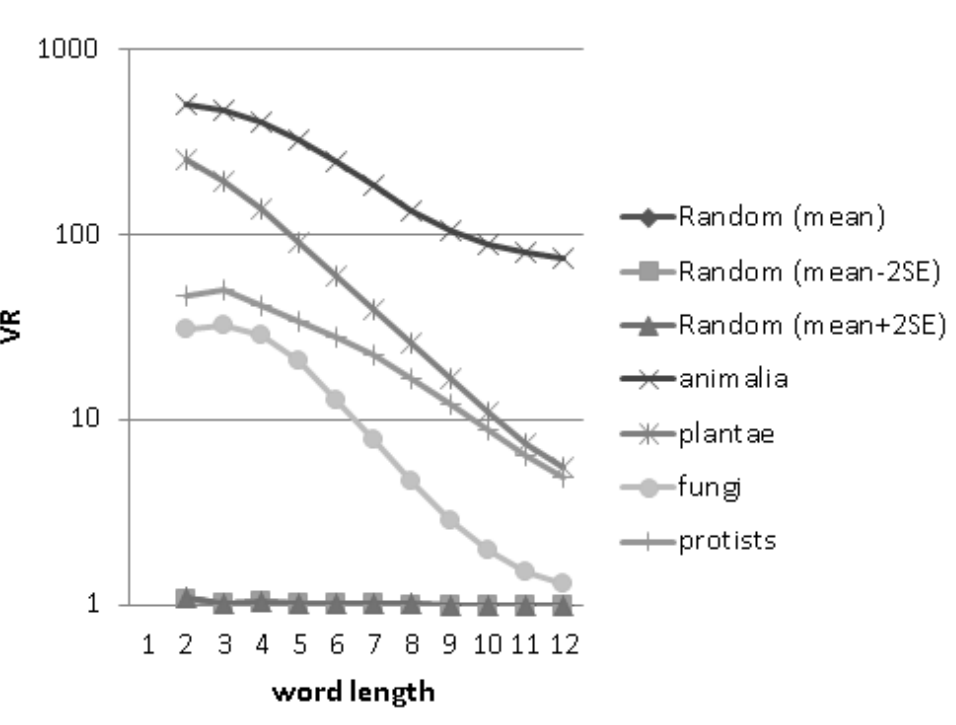
Figure 4: VR values for animalia, plantae, fungi, protists and random (mean and mean ± 2 × standard